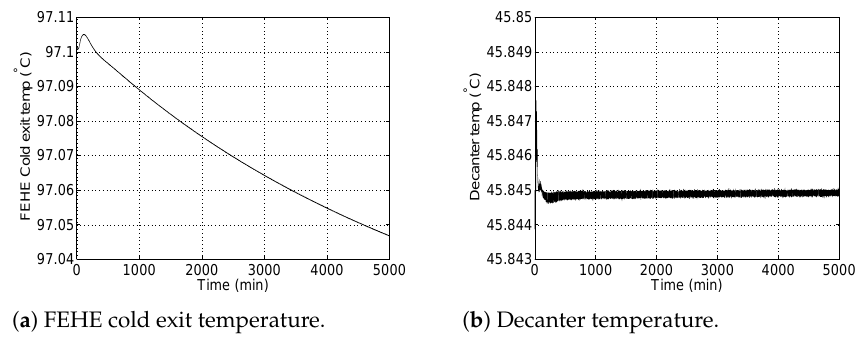
( b ) Decanter temperature. Figure 5. The normal operation of VAMP for two observed variables.